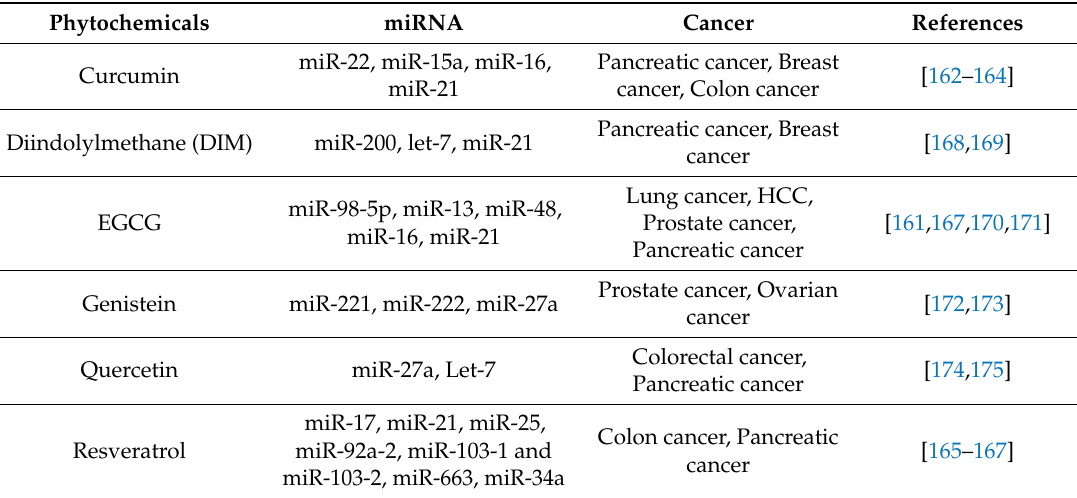
Table 1. Effects of phytochemicals on different types of cancer